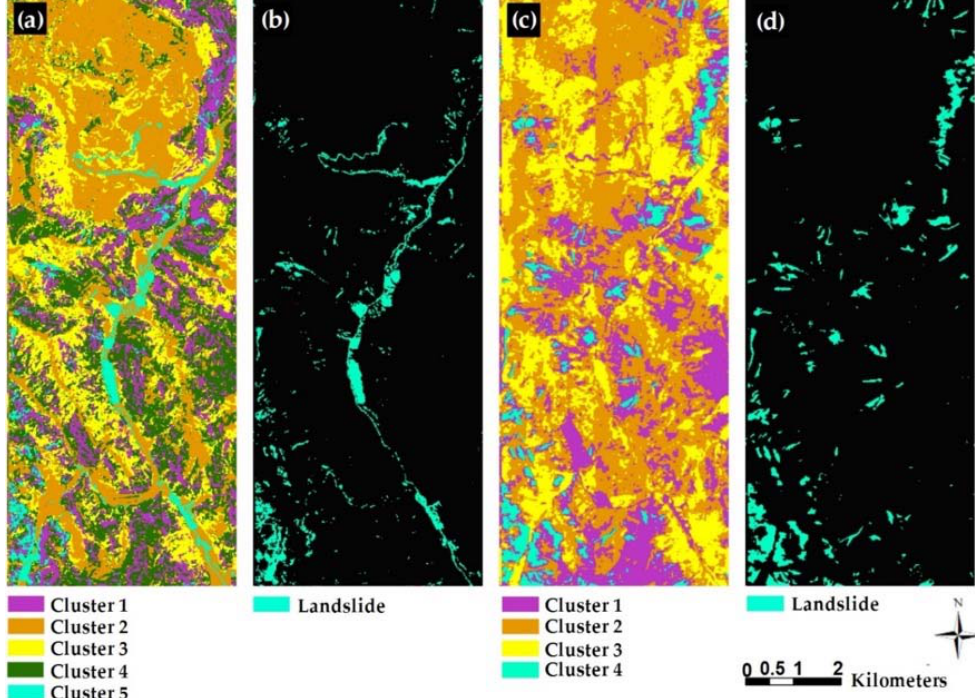
Figure 13. Clustering landslides in China’s case study. ( a , b ) Clustering and binary landslide map based on MNF features, slop, and NDVI, while that of ( c , d ) show the same features as well as the deep features.